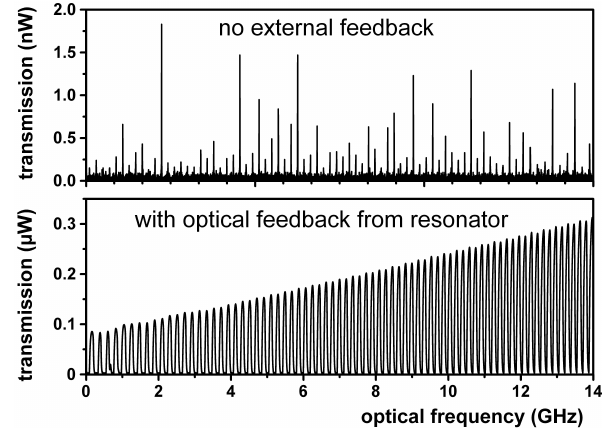
Fig. 5. Resonator transmission vs. relative laser frequency (at a wavelength of 408.9nm) during a piezo scan (14GHz=7.8pm at 408.9nm) of the laser grating (Horstjann et al., 2012). Freely run- ning ECDL (top); with the optical feedback from the high-finesse V-resonator (bottom). The signal slope is due to higher laser power at the end of the wavelength scan.